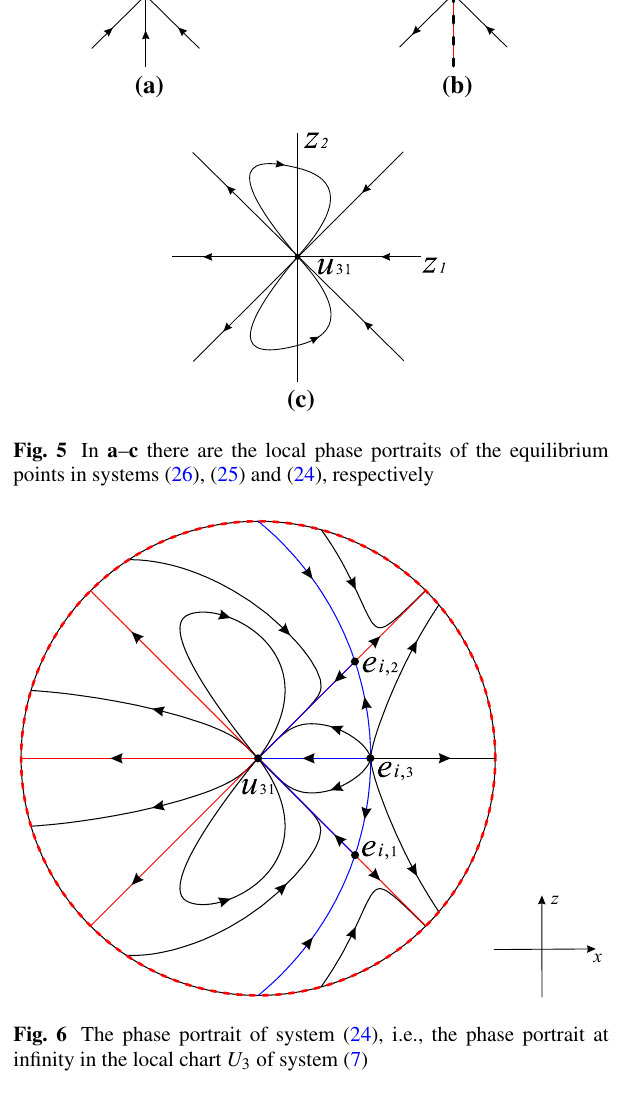
R 3 : z ≥ 0 , s ≥ 0 . R 4 : z ≥ 0 , s ≤ 0 .